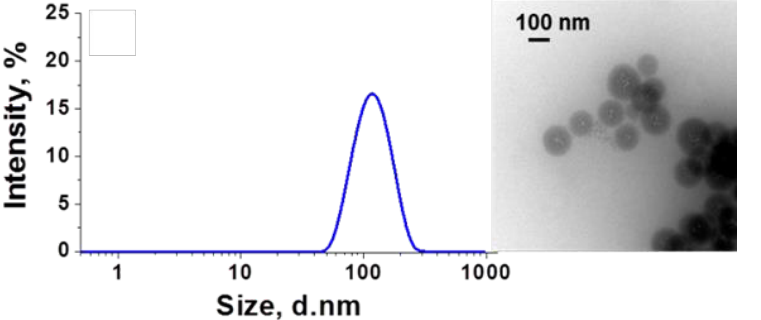
Figure 2. TEM and DLS images of the IA-16/PC modified liposomes with a molar ratio of 0.029/1, 25